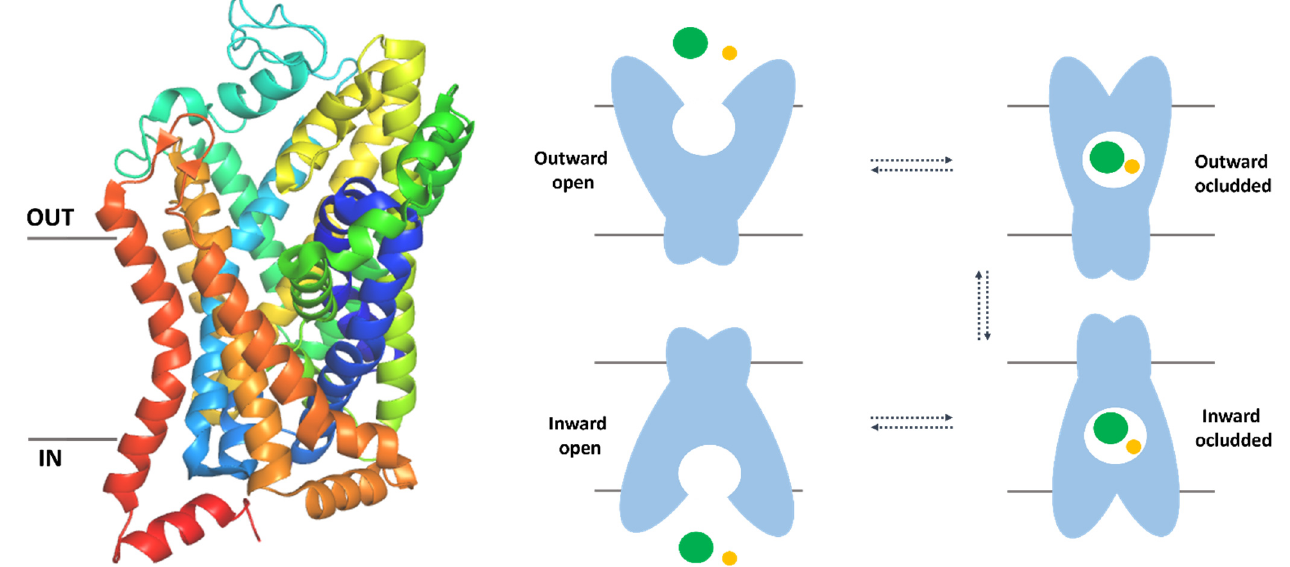
Figure 1. The overall structure of the SLC6 family transporters and mechanism of action. Crystal structure of dopamine transporter in outward–occluded conformation (PDB code: 4XPH). Helices are represented as cartoons ( left panel ). Schematic representation of different conformational states of transporters during transferring substrate (green sphere) and ions (yellow sphere) ( right panel ). Proteins revealed outward open state, outward occluded, inward occluded and inward open conformations [18,21].